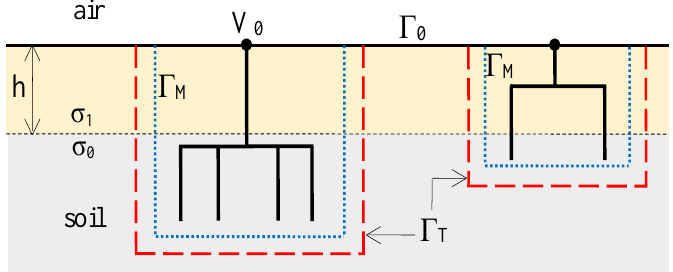
Figure 1. An active GS in the vicinity of another passive GS embedded in a two-layer soil.